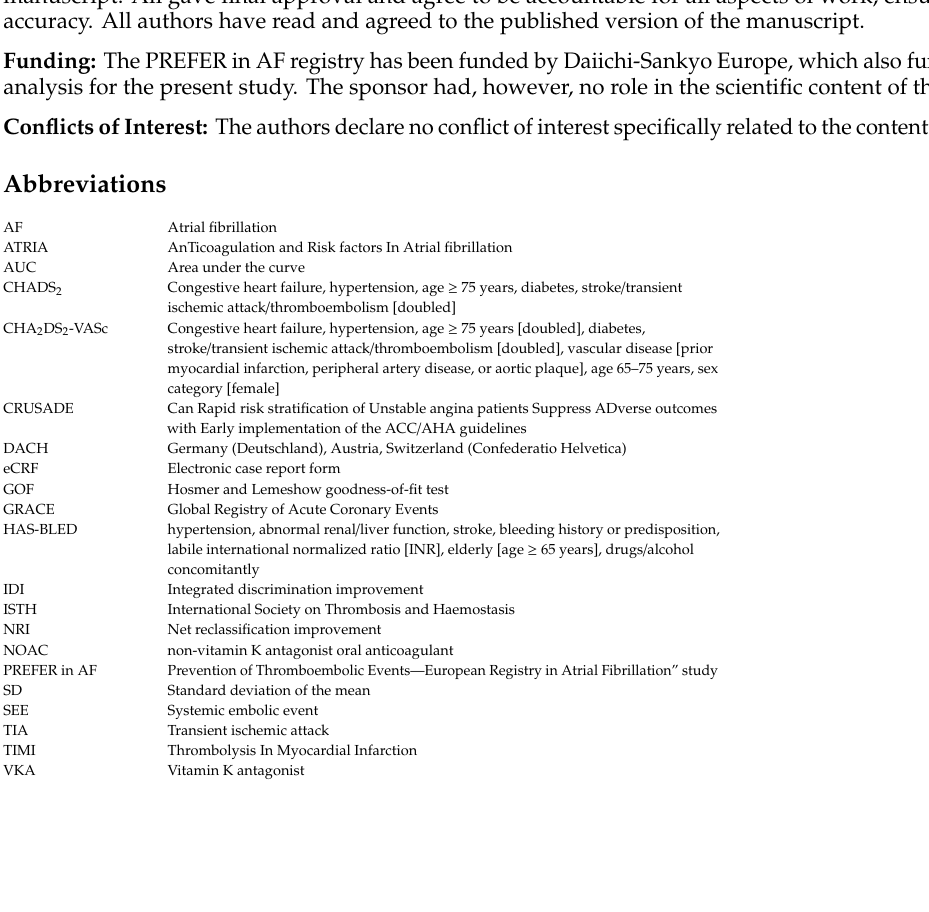
Table S1. Logit regression result with CHA 2 DS 2 -VASc scores as explanatory variables; Table S2. Logit regression result with HAS-BLED scores as explanatory variables; Table S3. Comparison C-statistic in subjects treated with NOACs vs. total population CHA 2 DS 2 -VASc scores as explanatory variables; Table S4. Comparison C-statistic of the